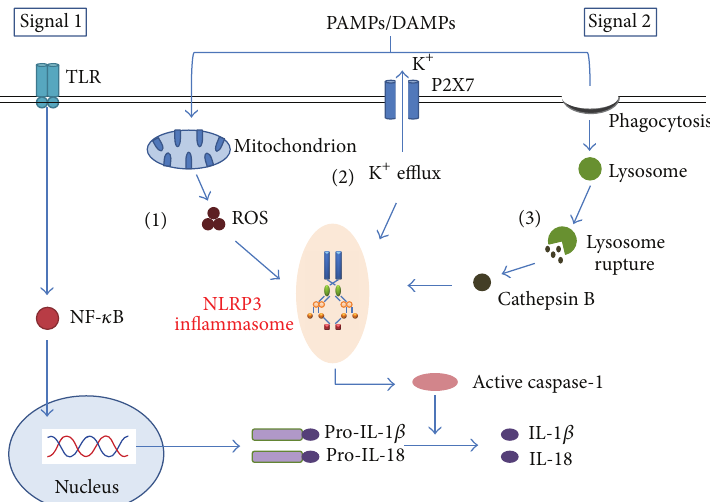
Figure 1: Models of NLRP3 inflammasome activation. Signal 1 activates the Toll-like receptor (TLR)/NF- 𝜅 B pathway, leading to the transcription of pro-IL-1 𝛽 and pro-IL-18. Signal 2 is mediated by PAMPs or DAMPs stimulation and promotes the assembly of NLRP3 inflammasome complex. Three main mechanisms of the NLRP3 inflammasome activation have been proposed. (1) Stimuli can trigger the production of mitochondrial ROS and then induce the NLRP3 inflammasome activity. (2) Extracellular ATP or bacterial toxins can induce K + efflux through the P2X purinergic receptor 7 (P2X7), which leads to the activation of the NLRP3 inflammasome. (3) The phagocytosis of specific crystalline can cause lysosomal rupture and induce the release of lysosomal contents cathepsin B, which contributes to the activation and assembly of the NLRP3 inflammasome. Consequently, these trigger the cleavage of procaspase-1 into its active and mature form caspase-1, which leads to the production of the mature IL-1 𝛽 and